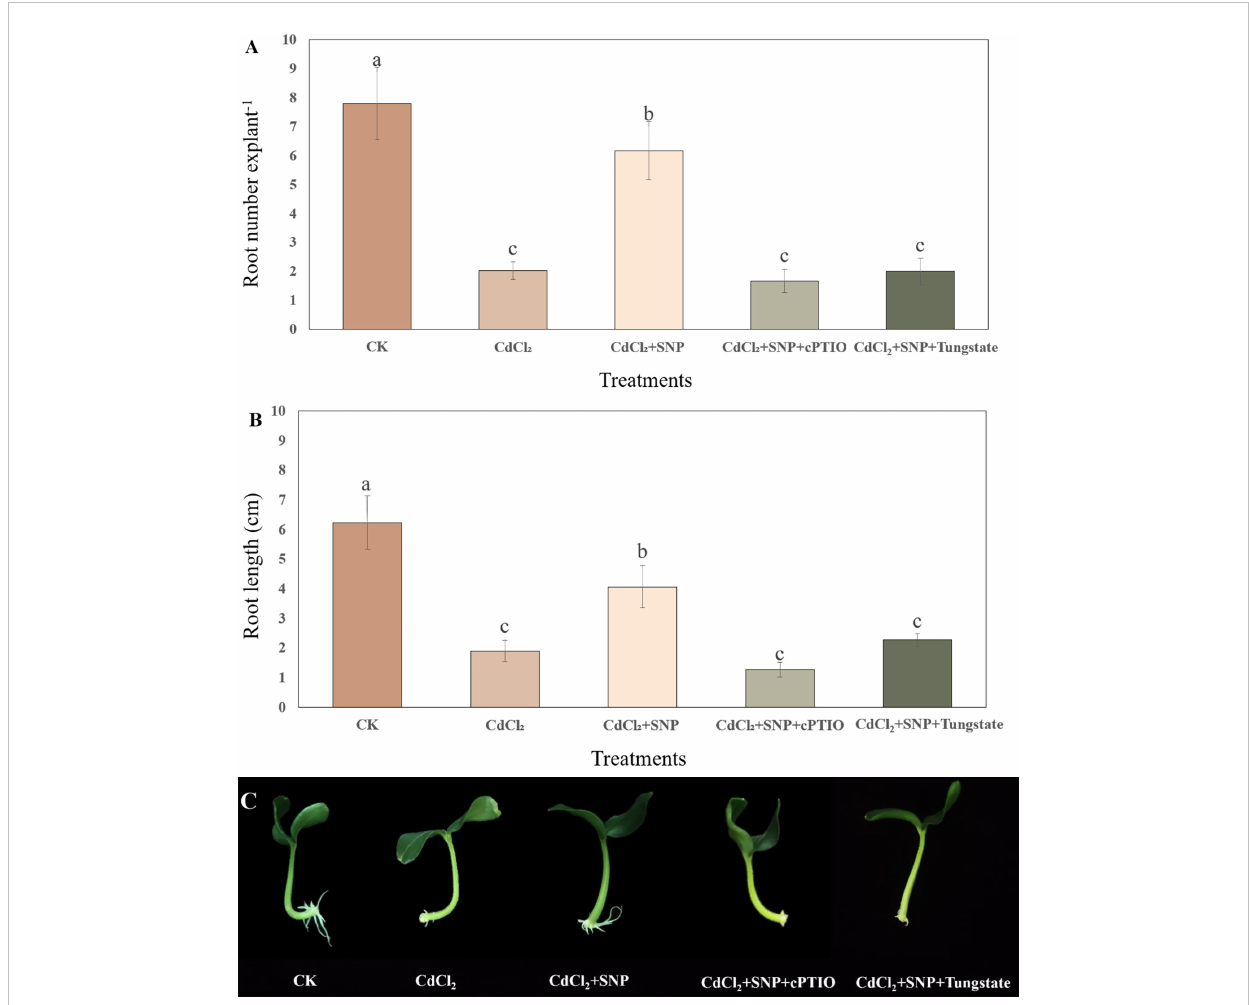
FIGURE 2 Effect of cPTIO or tungstate on adventitious root formation under Cd stress. The primary roots were removed from 5-day-old seedlings. Explants were then incubated for 5 days with distilled water (CK) or 1 m M CdCl 2 , 1 m M CdCl 2 +10 m M SNP, 1 m M CdCl 2 + 10 m M SNP + 200 m M cPTIO, 1 m M CdCl 2 + 10 m M SNP + 200 m M tungstate. Ten explants were used per replicate. The numbers (A) and root length (B) of adventitious roots were expressed as mean ± SE (n = 3). Photographs (C) were taken after fi ve days of the treatments indicated. Bars with different letters are signi fi cantly different at P < 0.05 according to Duncan ’ s multiple range